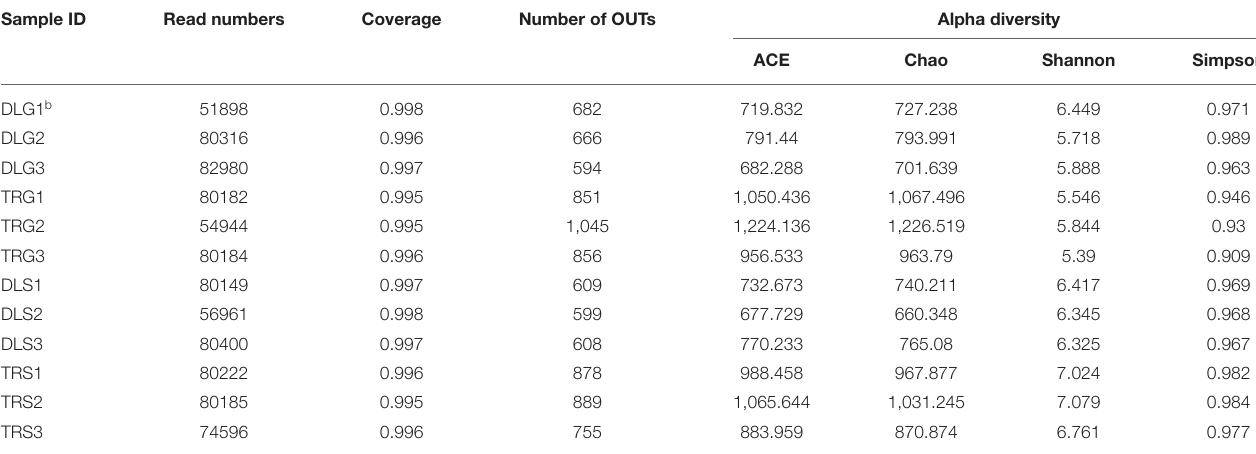
TABLE 1 | Richness and diversity indexes relative to each sample (OUT cutoff of 0.03) a